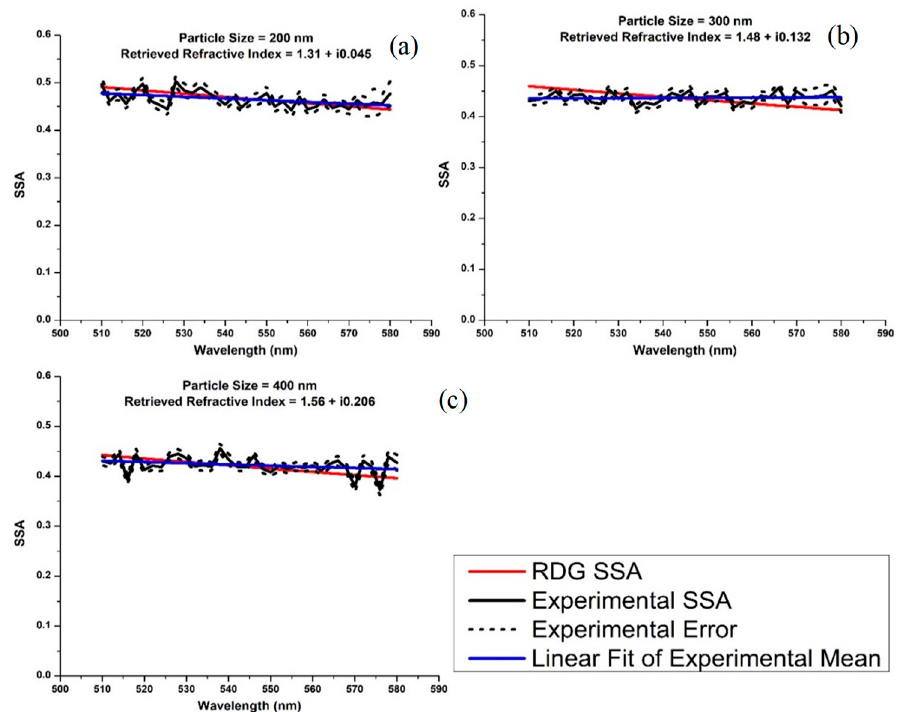
Figure 3. Comparison of measured and calculated cross sections for eucalyptus fuel, for ( a ) 200, ( b ) 300, and ( c ) 400 nm sized particles.